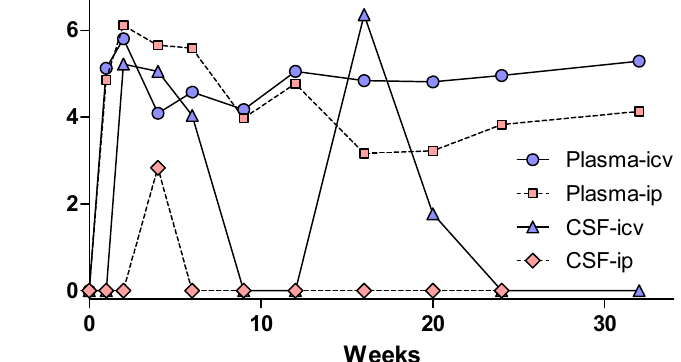
Figure 1. Example of the development of FIV titers in plasma and CSF after systemic (ip) or intracereroventricular (ICV) inoculation of specific pathogen free cats with 2 × 10 5 copies of FIV. In both cases plasma viremia develops rapidly, peaking at 1–2 weeks post-inoculation. The sustained plasma viral load is maintained at higher levels after ICV inoculation (blue circles). CSF viral titers (blue triangles) closely parallel the acute plasma virus and occasionally exceeds plasma titers indicating a CNS origin. Chronic CSF FIV titers may show independent spikes of activity and generally average about 10 3 –10 4 copies/mL. Following systemic inoculation, FIV titers in CSF show a modest delayed peak followed by relative recovery to low levels.